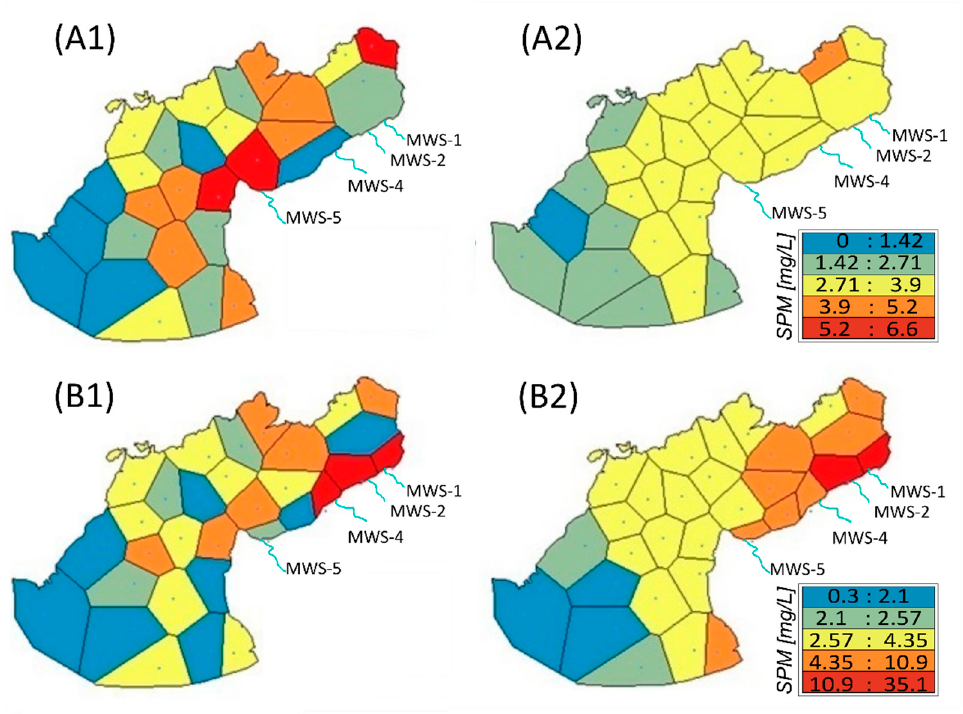
Figure 4. Simple ( A1 , B1 ) and mean ( A2 , B2 ) Voronoi interpolation map for one-day suspended particulate matter (SPM) data without meltwater streams -MWS- input ( A1 , A2 ) and with MWS ( B1 , B2 ). Interpolated SPM concentrations in (mg/L) differ by data set and Voronoi type used, where blue means low, green mid-low, yellow middle, orange mid-high, and red high SPM concentration. Light blue lines show meltwater streams (MWS); thus, the source of SPM discharges into the cove.